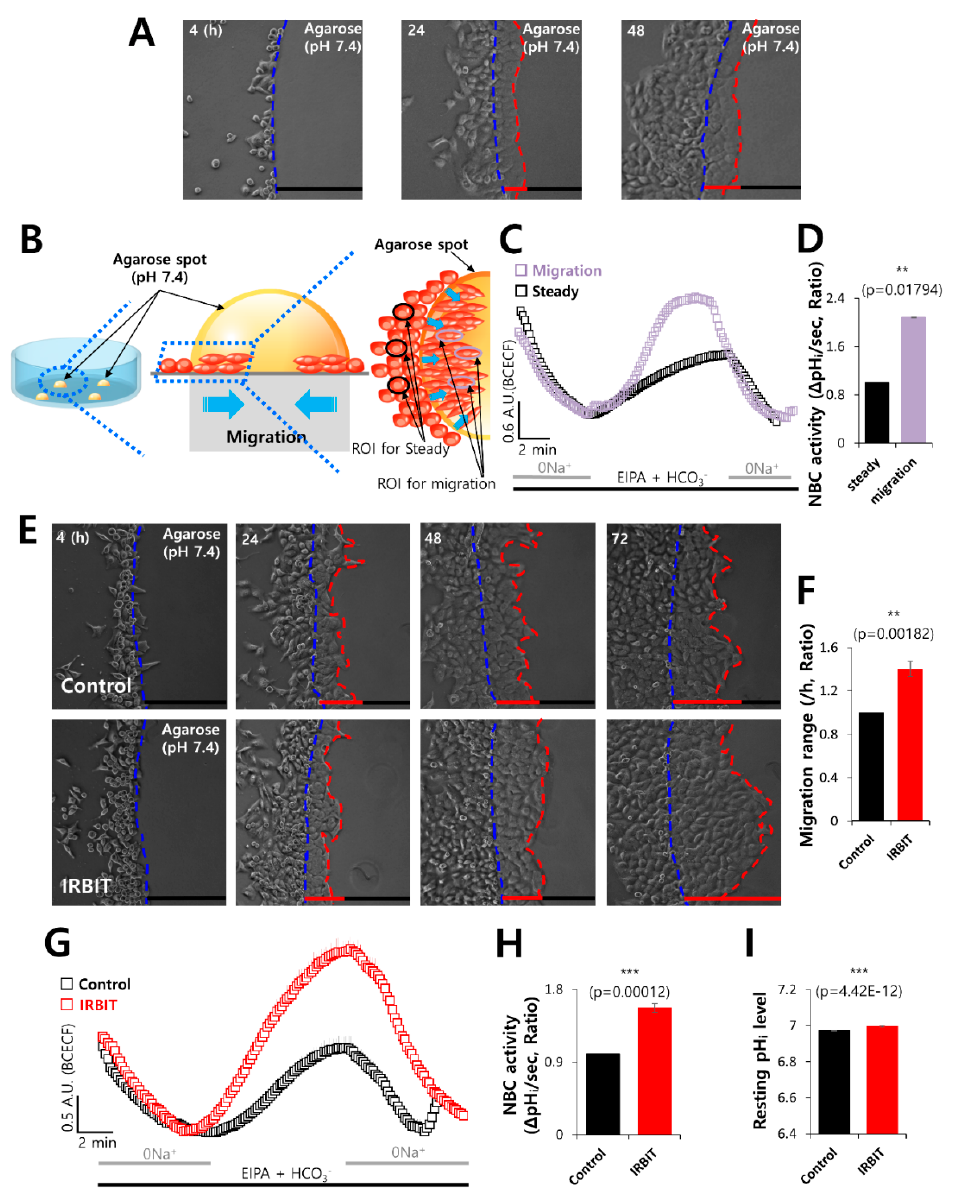
Figure 1. IRBIT enhanced cell motility via NBC. ( A ) Time-dependent representative images of the migration of A549 cells toward the agarose spots containing PBS (pH 7.4) for indicated times. The blue dotted lines indicate the direction of migration across the boundary of the agarose spot, which is indicated by a dashed curve. The red dotted lines indicate the lineage of cells that migrated toward the agarose spots. ( B ) Schematic illustration of agarose spots containing PBS (pH 7.4), with the red dotted lines indicating the region of interest (ROI) of migration area, and the blue dotted lines indicating ROI of steady area. ( C ) NBC activity in migration state (violet open square) and steady state (black open square) of A549 cells in the agarose spots at 48 h. Averaged traces are presented. ( D ) The bars indicate the mean ± SEM of data obtained from five experimental replicates ( n = 5). ( E ) Time-dependent representative images of the migration of A549 cells toward the agarose spots containing PBS (pH 7.4), with or without IRBIT. ( F ) Analysis of the migration range per hour. The bars indicate the mean ± SEM of data ( n = 10). ( G ) NBC activity in the A549 cells with (red open square) or without (control, black open square) IRBIT at 48 h. Averaged traces are presented. ( H ) The bars indicate the mean ± SEM of data ( n = 5). ( I ) The bars depict the resting pH i level of A549 cells and indicate the mean ± SEM of data ( n = 30).